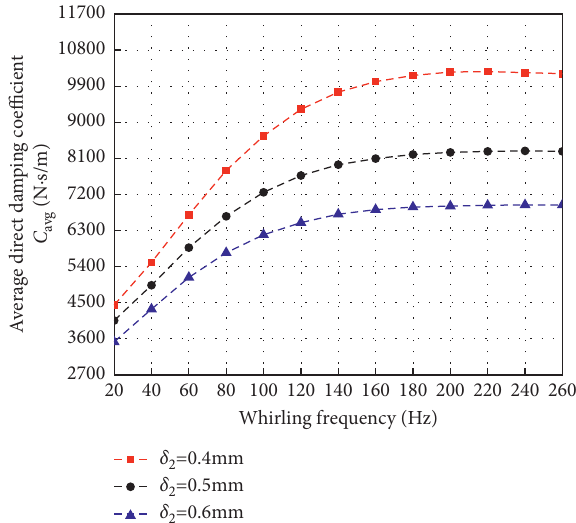
Figure 26: Average direct damping coefficient vs. whirling frequency.